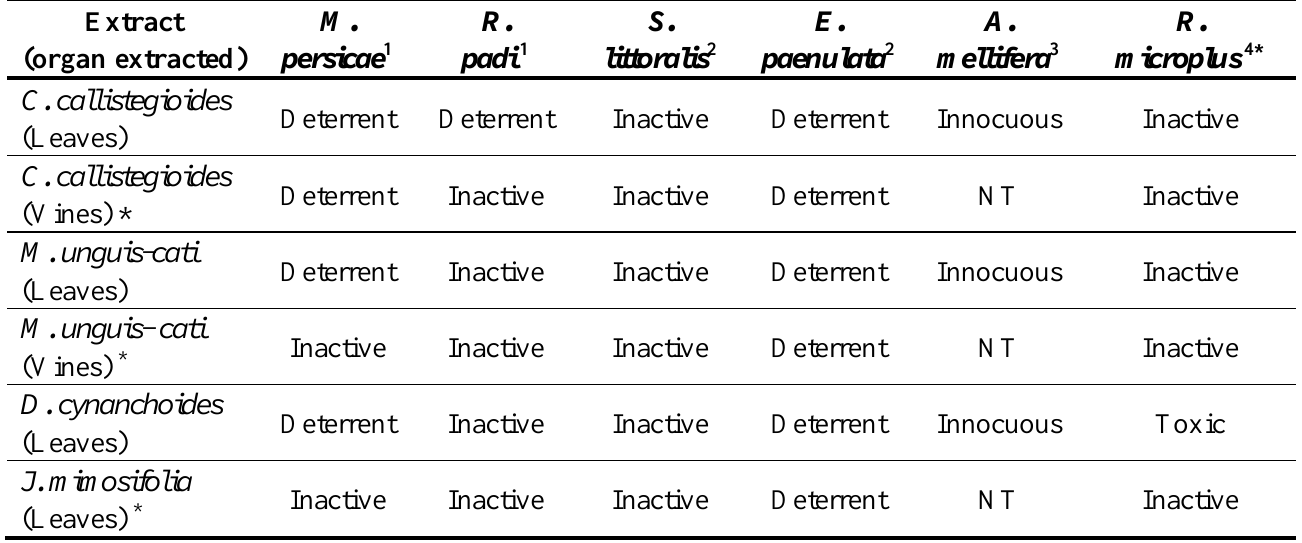
Table 2. Bioassay results for the different anti-arthropod activities in plant extracts from Uruguayan native